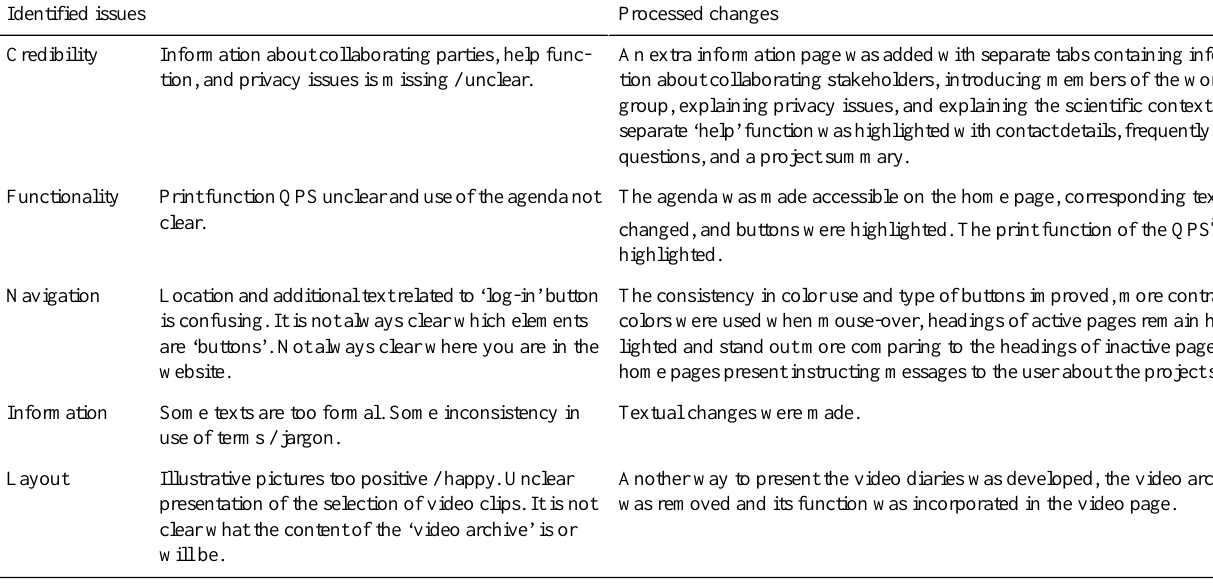
Table 1. Summary of identified credibility and usability issues.